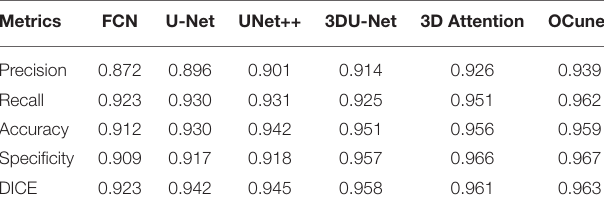
TABLE 1 | Comparing different methods with the proposed dataset on the liver tumor segmentation task.